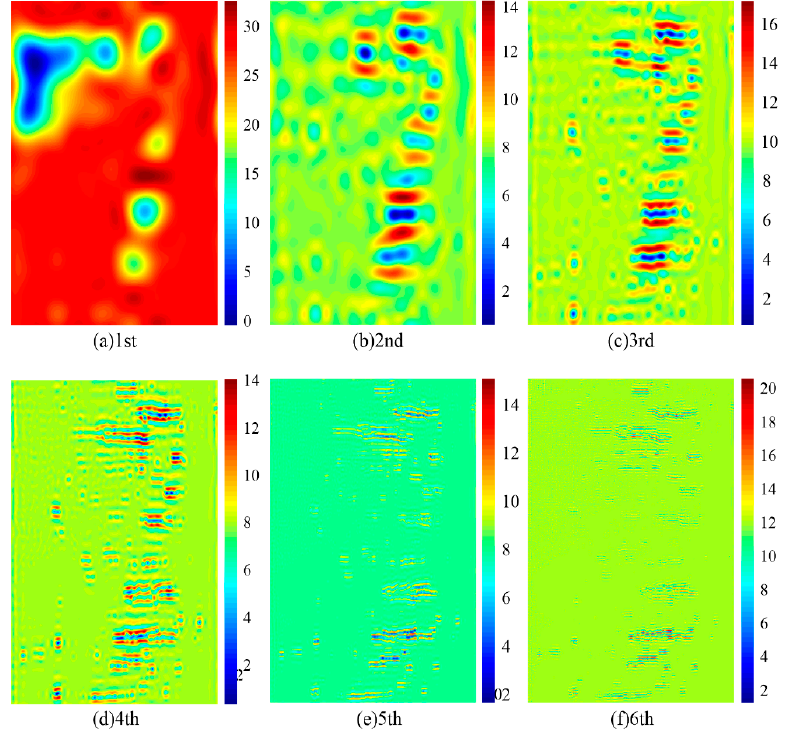
Figure 4. Contour single-layer coefficients from 1 to 6: ( a ) the first layer; ( b ) the second layer; ( c ) the third layer; ( d ) the fourth layer; ( e ) the fifth layer; ( f ) the sixth layer.